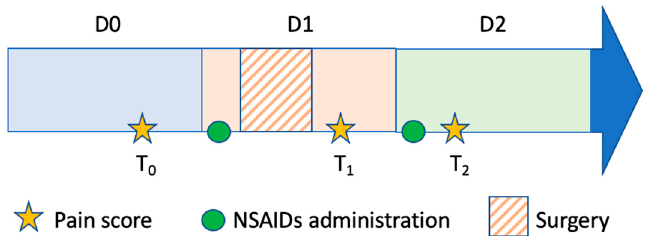
Figure 1. Study protocol. NSAID was administered 1 h before surgery and 24 h later. Pain scores were assessed before NSAID administration (T 0 ), after recovery from anesthesia (T 1 ) and after the second NSAID administration (T 2